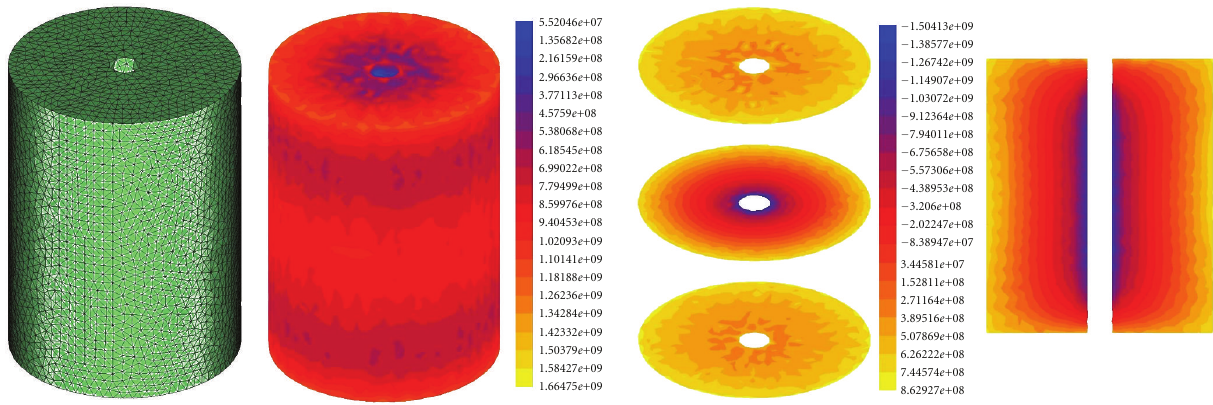
Figure 13: 3D finite elements mesh; von Mises equivalent stresses and tangential stresses (at three di ff erent pellet heights and at an axial cut) for a hollowed pellet.